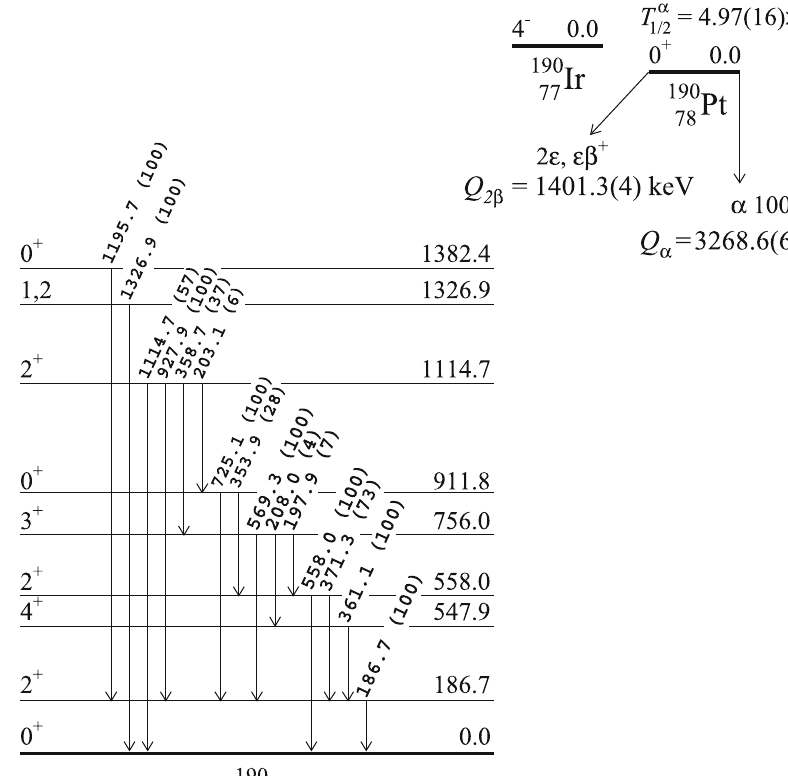
Fig. 1 A simplified decay scheme of 190 Pt [27]. The energies of the excited levels and of the emitted γ quanta are in keV (the relative intensities of the γ quanta are given in parentheses). Q 2 β and Q α are the double-beta decay and alpha decay energies of 190